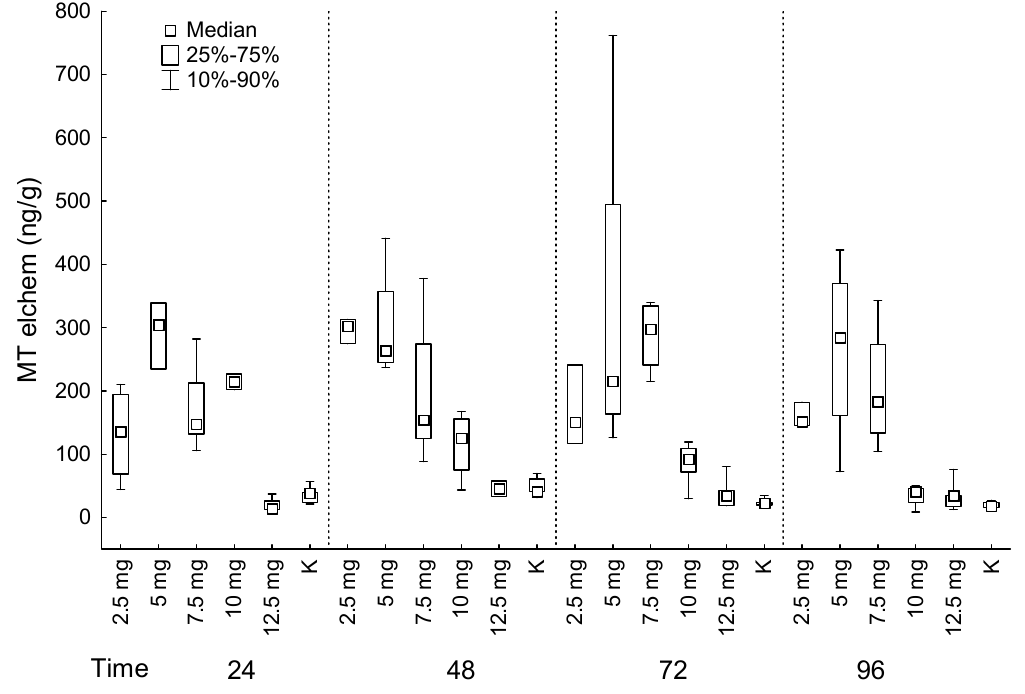
Figure 3. LIVER: MTs (ng/g) in fish grouped according the exposition to cadmium chloride (mg/L) (K–control